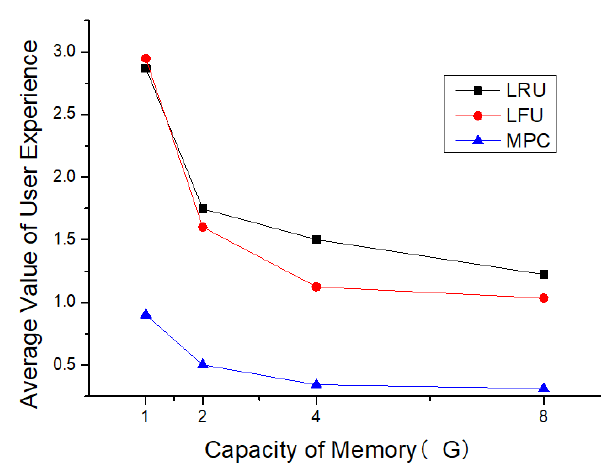
Fig. 4 The effect of cache capacity on user